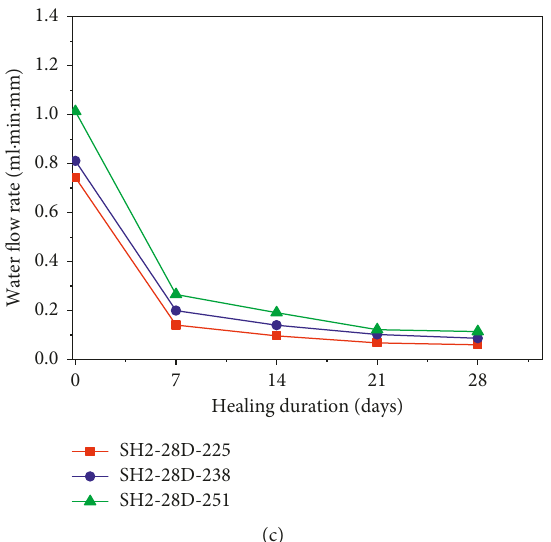
Figure 8: Water flow rate versus healing duration for three mixes at the healing periods of 0, 7, 14, 21, and 28 days: (a) OPC; (b) SH1; (c) SH2.